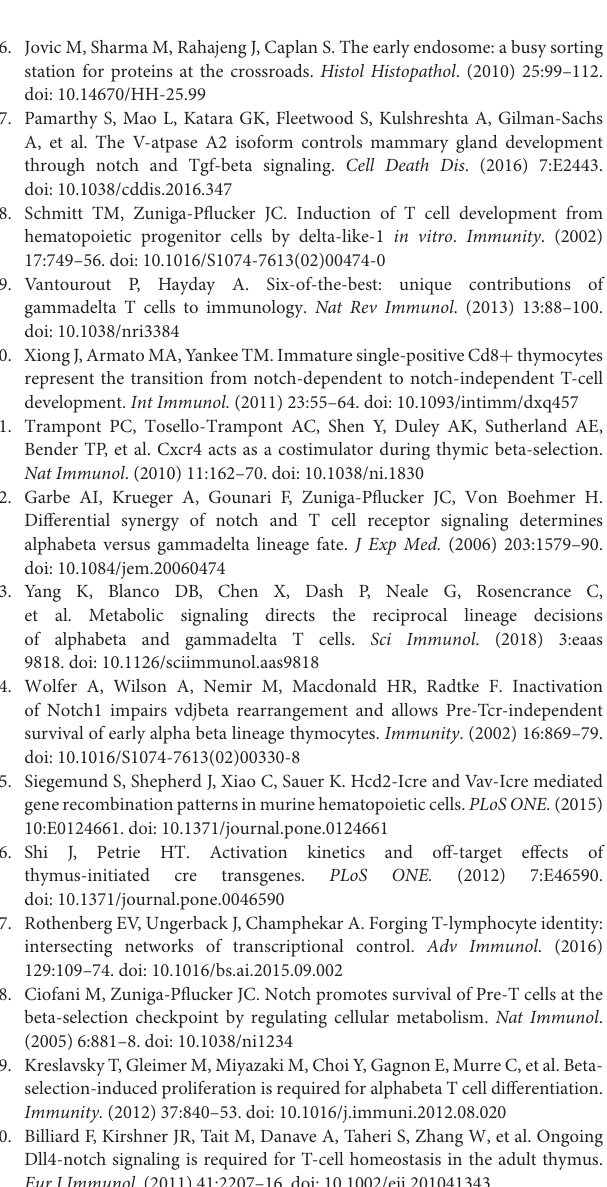
Figure S1 | Flow cytometry analysis of selected myeloid subsets. (A) Representative flow and (B) quantification of major functional myeloid subsets. RPMac, red-pulp macrophages (CD11b lo CD11c lo F4/80 + ); Mac, conventional macrophage (CD11b hi F4/80 + ); InfMo, inflammatory monocyte (CD11b hi Gr-1 + ); MoDC, monocyte derived dendritic cell (CD11c hi CD11b + F4/80 + ). n.s. = no significance. ∗ p < 0.05. Figure S2 | Analysis of TGF β signaling components. Western blots of SMAD2/3 and P-SMAD2 in cytoplasmic and nuclear lysates from sorted DN